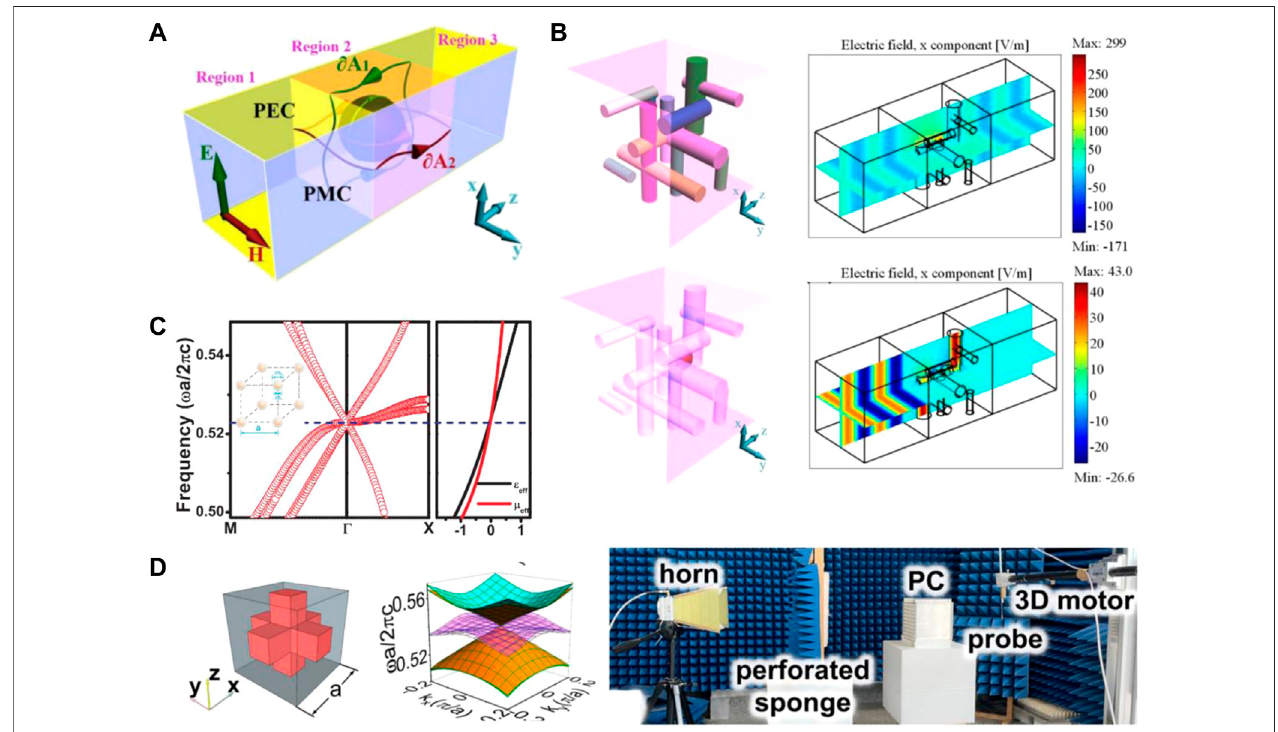
FIGURE5|(A) Schematicofunusualpercolationofelectromagnetic wavesina3Dimpedance-matchedZIMhostwithdefects. (B) Upper:schematicdiagramofa 3D ZIM host embedded with random dielectric cylinders below the percolation threshold (left), and the simulated electric- fi eld distribution, showing perfect transmission ofelectromagneticwaves(right).Lower:schematicdiagramofthecasebeyondthepercolationthreshold(left),andthesimulatedelectric- fi elddistribution,showingnear- zero transmission(right). Reproduced withpermission from Ref.[62]. (C) Atheoretical designof3DZIMusing a3D PhCconsisting ofasimplecubiclatticeofcore- shell spheres. A Dirac-like cone composed of sixfold degenerate modes is observed at the Γ point, and the effective parameters satisfy ε eff (cid:2) μ eff (cid:2) 0 at the Dirac-point frequency.ReproducedwithpermissionfromRef.[148]. (D) Amicrowaveexperimentalrealizationofthe3DPhCwithaDirac-likeconefor3DZIM.ThePhCiscomposed of dielectric meshes. Reproduced with permission from Ref.